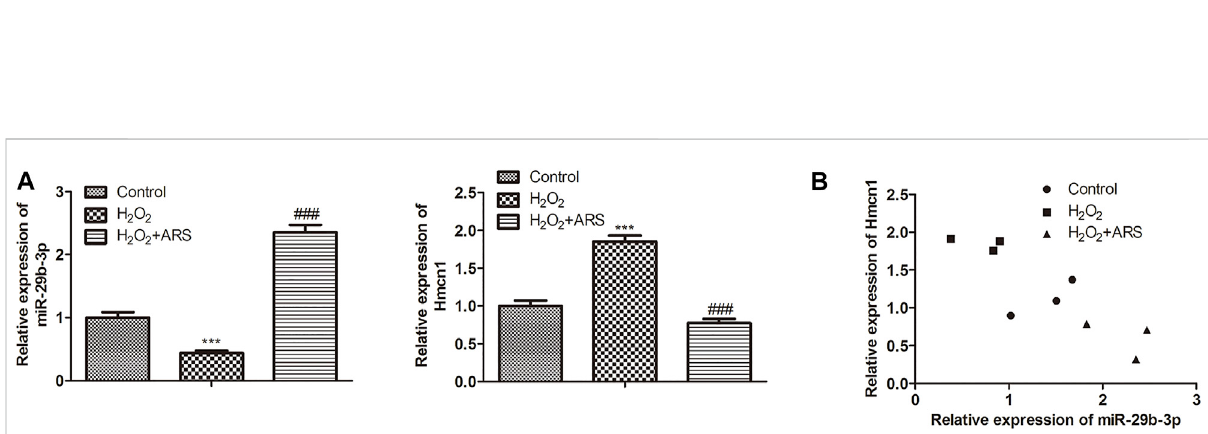
FIGURE 3 MiR-29b-3p and HMCN1 are the target genes of ARS. (A) MiR-29b-3p and HMCN1 was determined; (B) Pearson ’ s correlation analysis was applied to analyze the relationship between miR-29b-3p and HMCN1. N = 3, *** p < 0.001 vs. Control; ### p < 0.001 vs. H 2 O 2 .